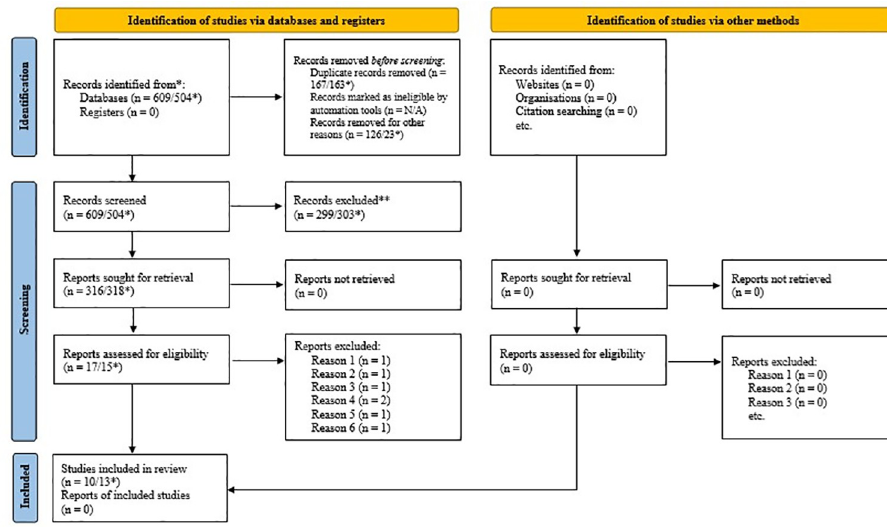
Fig 1. Flow diagram describing the study selections from literature searching. � Update